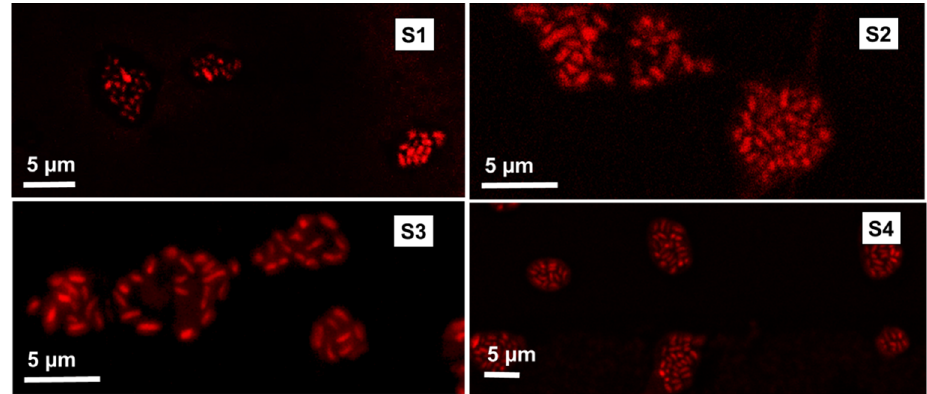
Figure 4. Confocal microscopy images of the Bifido encapsulated within the electrosprayed ETC core–shell microcapsules.